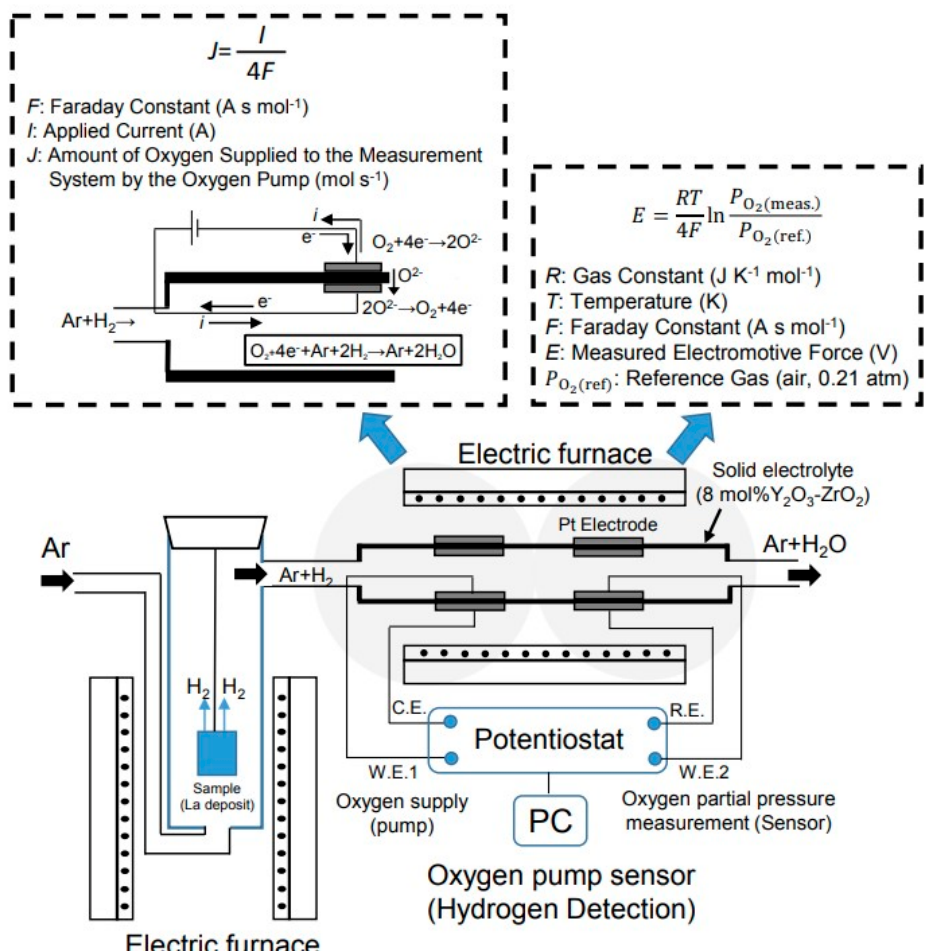
Figure 2. Diagram of measuring device for hydrogen storage capacity of LaNi 5 hydrogen storage